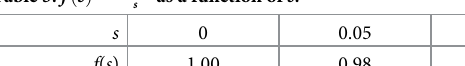
as a function of s . s s 0